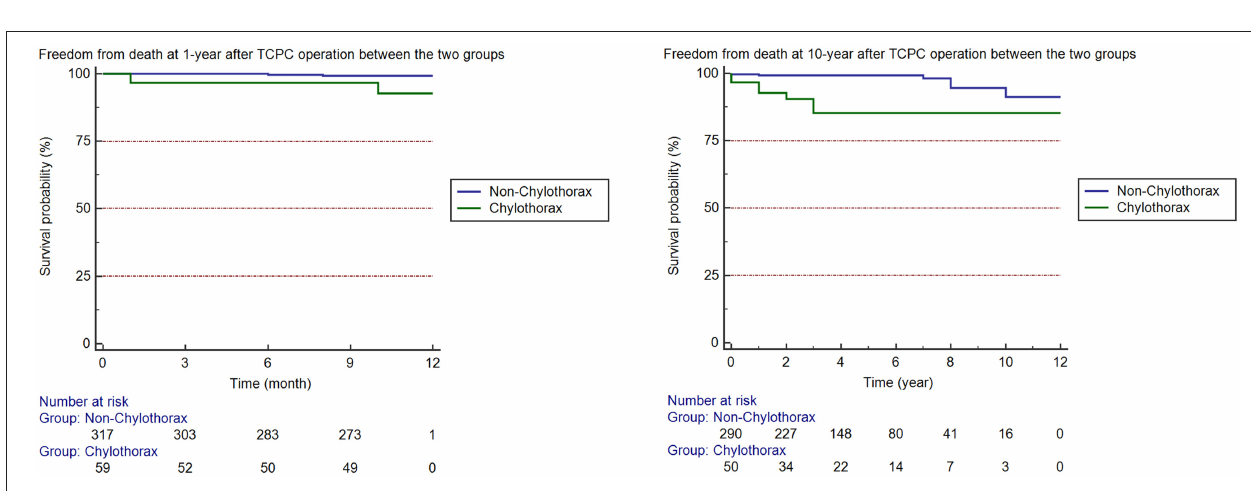
FIGURE 3 | Freedom from death at 1 and 10 years after TCPC operation between the two